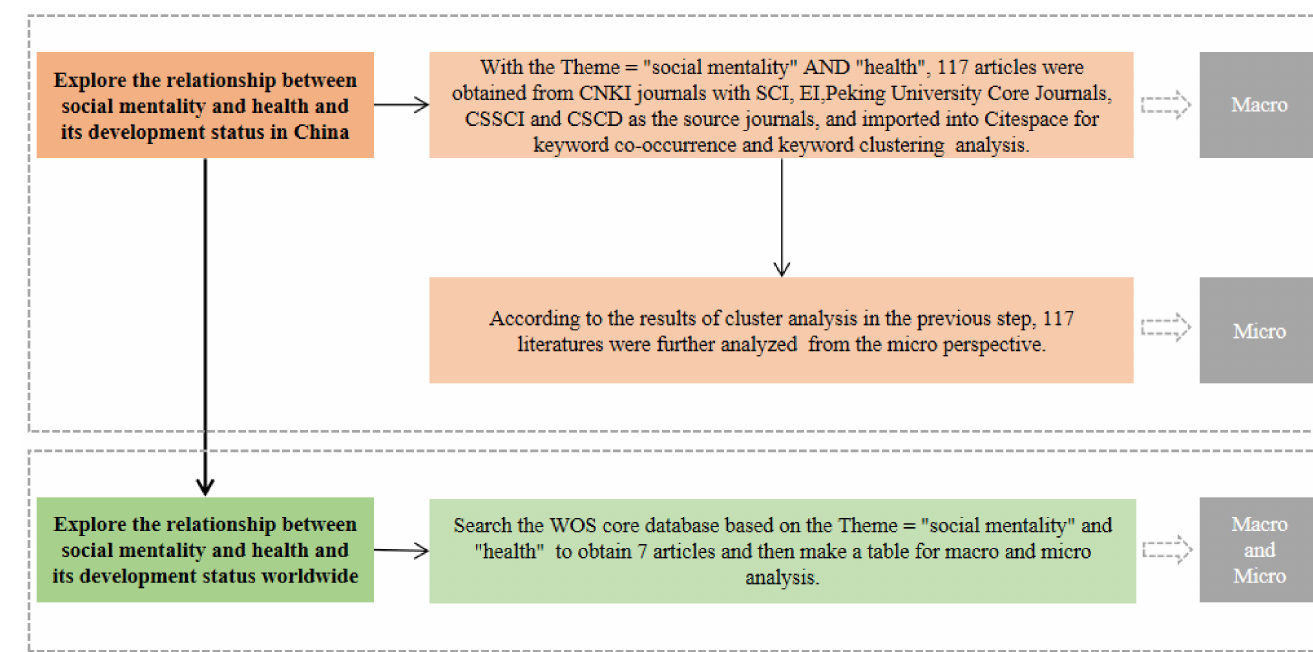
Figure 1. Research flow chart (generated by